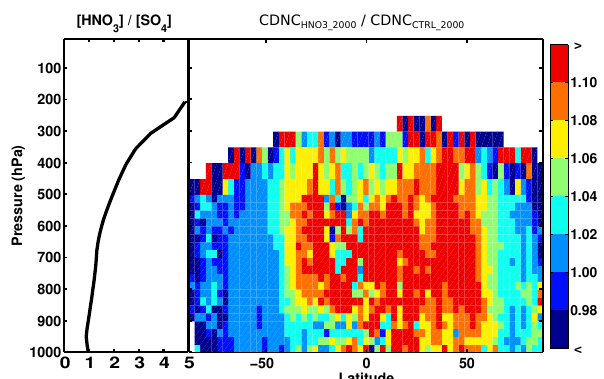
Fig. 2. Ratio of nitric acid mass vs. sulfate mass in Aitken and accumulation modes (left panel) and 20-year zonal average ratio of CDNC between simulations with (HNO3 2000) and without (CTRL 2000) nitric acid (right panel).